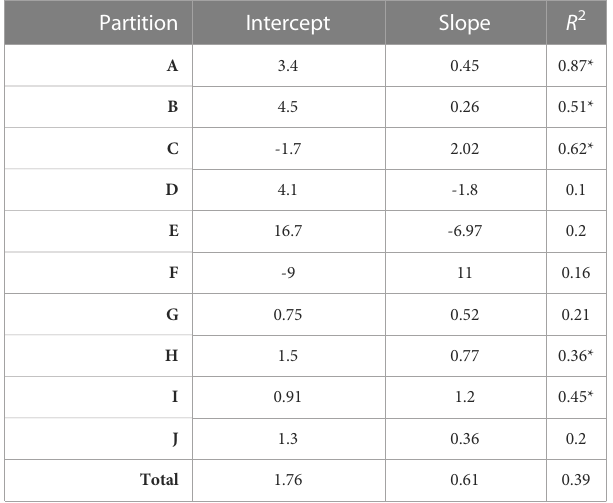
TABLE 1 The intercept, slope and variance explained (R 2 ) for each linear regression comparing observed and modelled zooplankton biomass (DAT CM against MOD CM ) within each partition (n=36) and total (n=360).